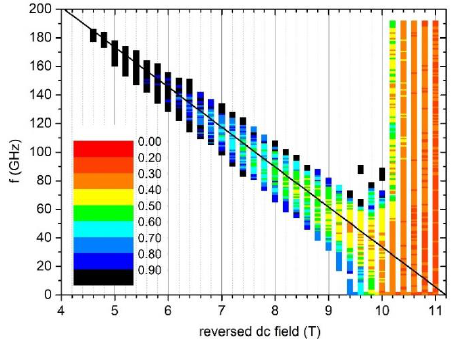
Figure 5. Conditions (exciting frequency vs. applied reversed field) under which reversal occurs within 1 ns for a CoPt disk with diameter D = 60 nm and thickness t = 4 nm. The color code represents the switching time in nanoseconds. A particular color is used for switching time, which is between the values indicated at its two edges. The solid black line represents the Kittel condition 𝑓 = 𝛾 (11.2 𝑇 − 𝐻) .